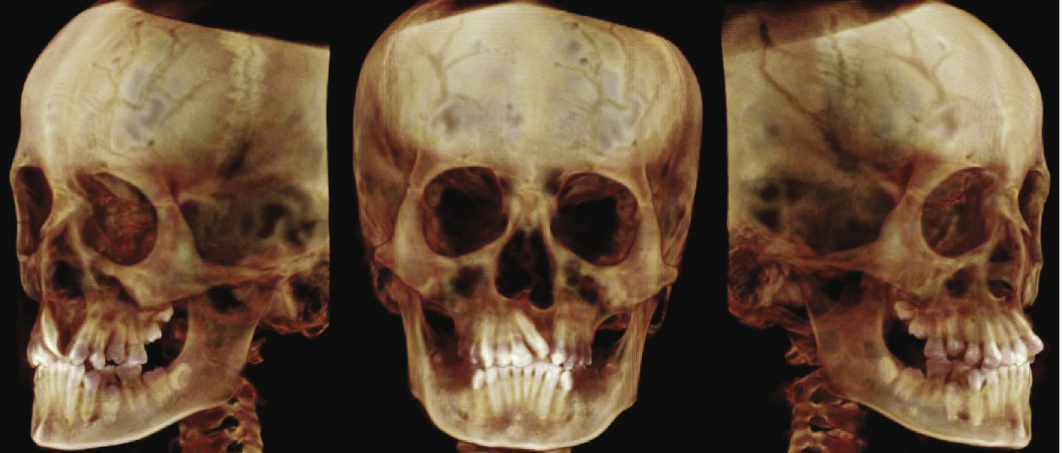
Figure 5: Cone-beam computed tomography.